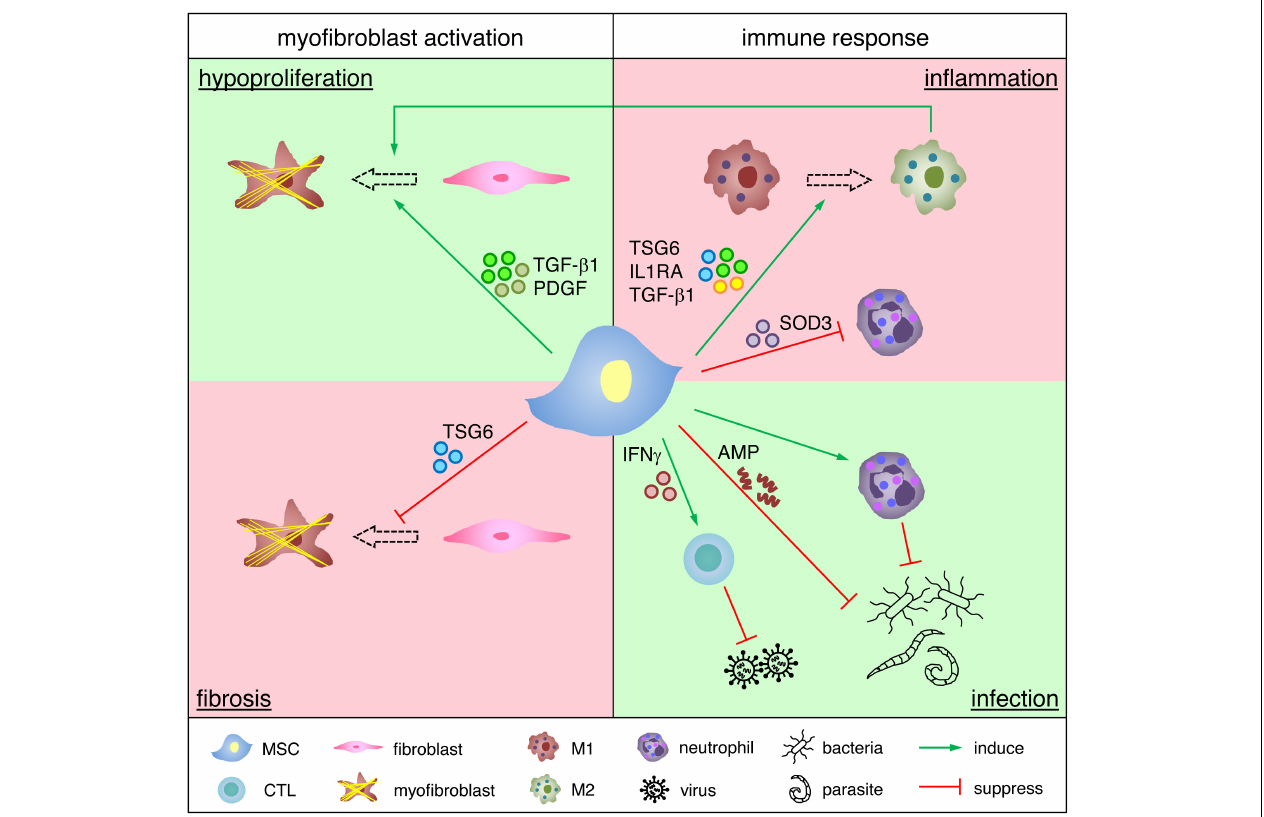
FIGURE 1 | Functional roles of MSCs in regulating granulation tissue formation. MSCs promote fibroblast proliferation and myofibroblast differentiation in a hypoproliferative environment, whereas they suppress myofibroblast activation and reduce myofibroblast numbers in a fibrotic environment. MSCs induce M1 to